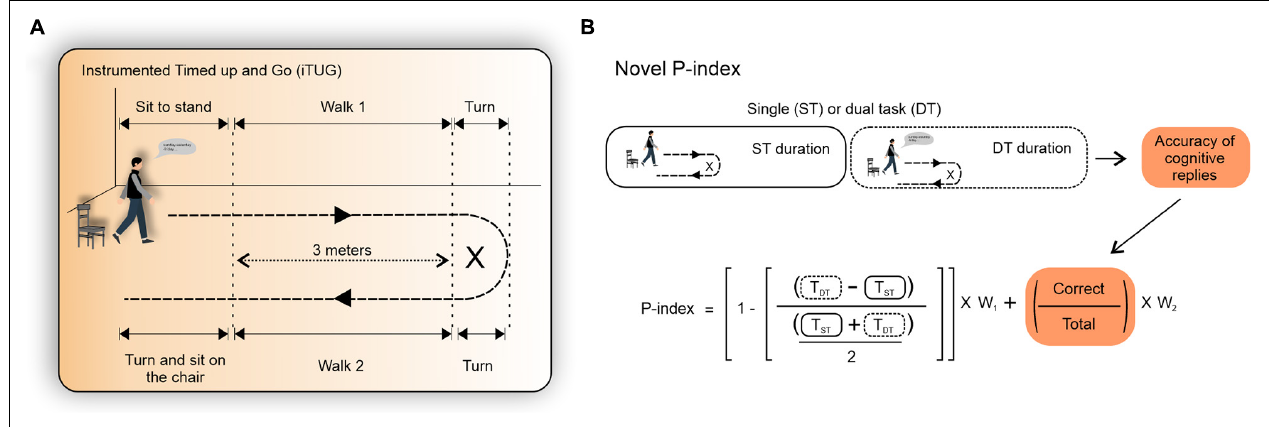
FIGURE 1 | The instrumented timed up and go (iTUG) test, the dual task cost (DT-C), and the novel performance index (P-index). (A) The iTUG test. (B) The accuracy of the cognitive replies during the DT (orange–defined as the ratio of correct vocalizations and total vocalizations) was included in the time-delta equation for calculating the cost of the dual task (DT-C) (Asai et al., 2018). The P-index is a novel index adjusted by the accuracy of the DT. Higher P-index values indicate greater DT performance. We tested the influence of the cognitive task (i.e., correct/total vocalizations) by increasing W 2 and decreasing W 1 at 0, 0.1, 0.2, 0.3, 0.4, 0.5, 0.6, 0.7, 0.8, 0.9, and 1, respectively.